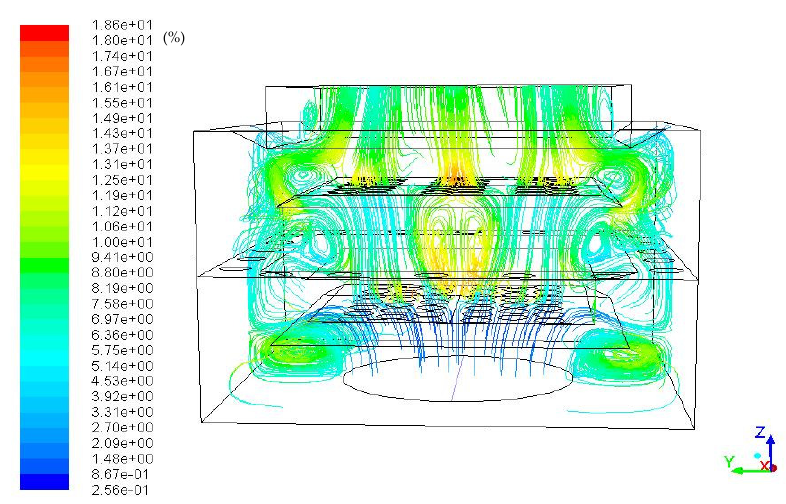
Figure 7. CFD-simulated turbulence intensity pathlines in non-powered hydraulic mixing at inlet water velocity of 0.5 m/s.